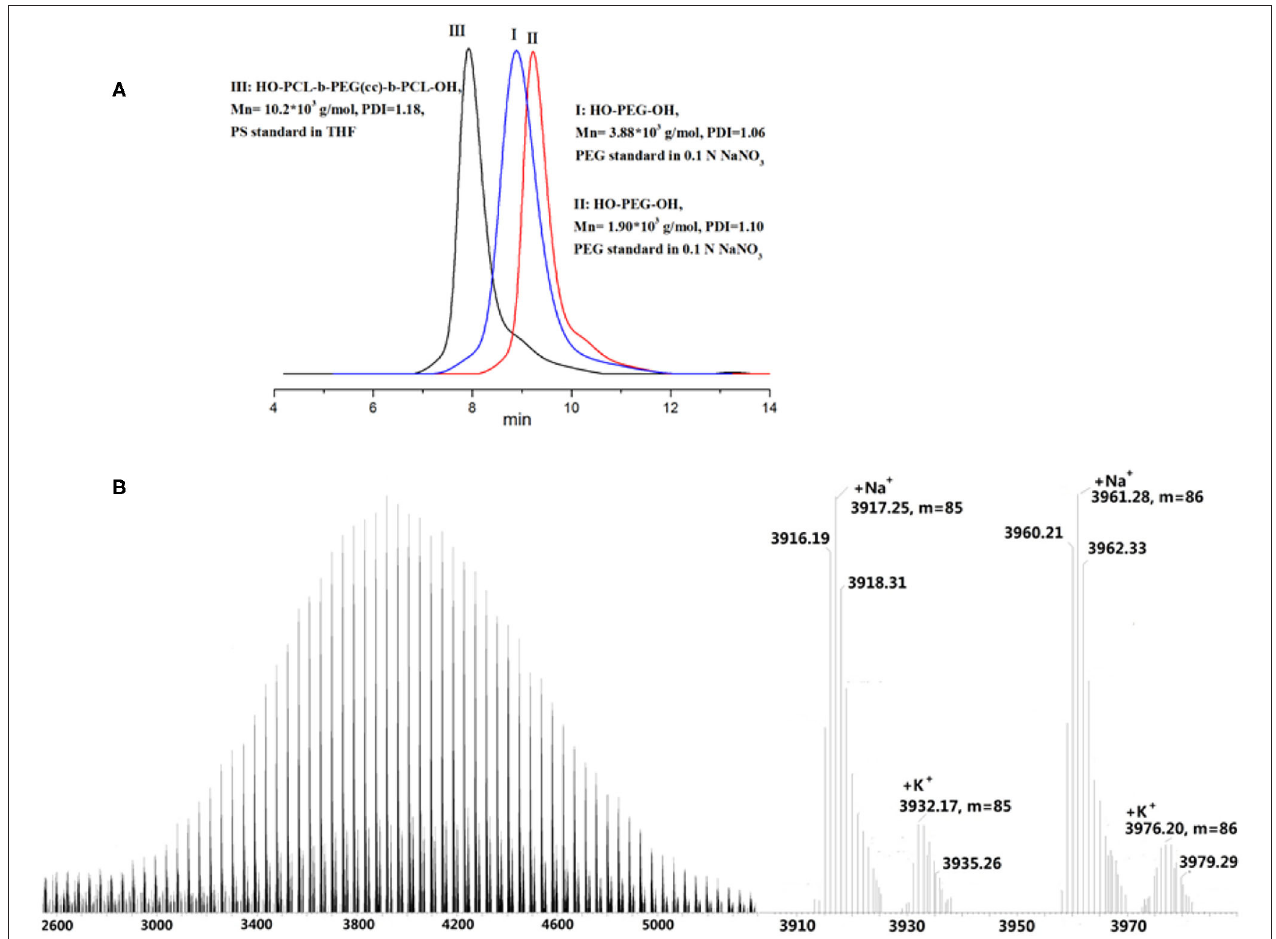
FIGURE 2 | (A) SEC profile of HO-PEG(ca)-OH (I) (M n = 3.88 × 10 3 g/mol, PDI = 1.06), its degradable residue HO-PEG-OH (II) (M n = 1.90 × 10 3 g/mol, PDI = 1.10), and triblock copolymer HO-PCL-b-PEG(ca)-b-PCL-OH (III) (M n = 10.2 × 10 3 g/mol, PDI = 1.18); (B) MALDI-TOF mass spectrum of HO-PEG(ca)-OH (M n(SEC) = 3.88 × 10 3